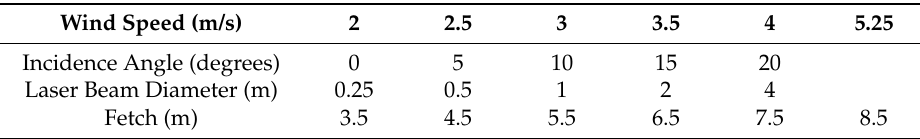
Table 1. The parameters used in the Monte Carlo ray tracing